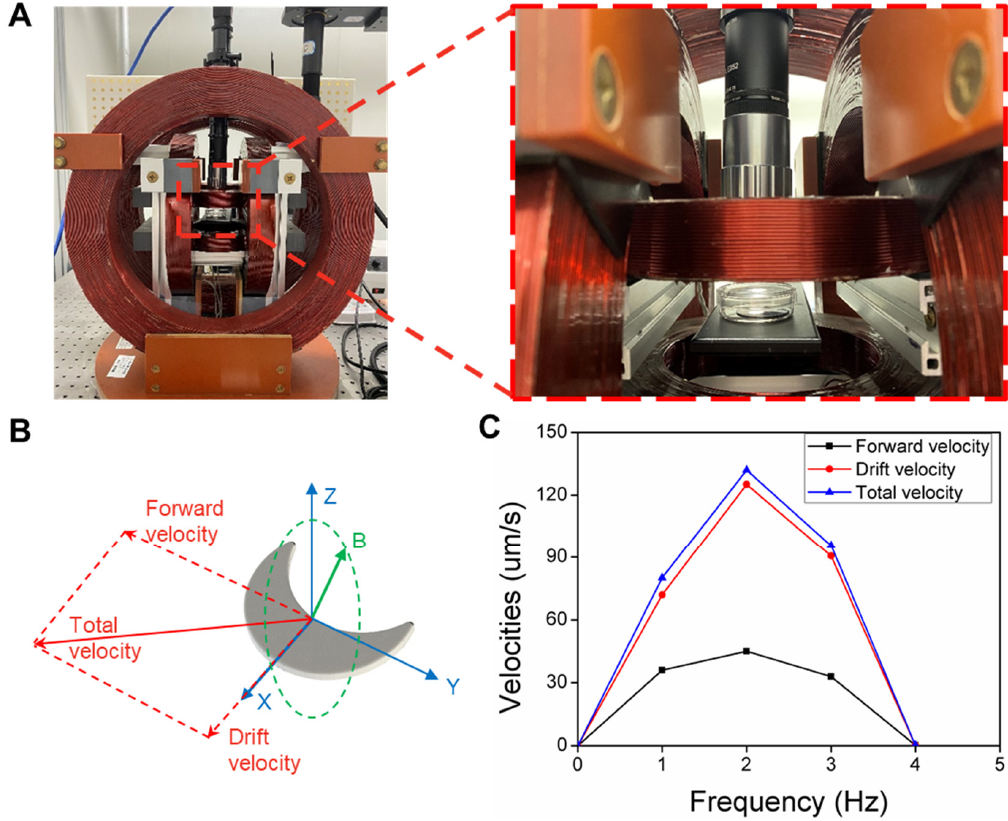
Figure 5. Biocompatibility test of the hydrogel crescent microswimmers. ( A ) Photograph of the magnetic control system. The zoomed-in image shows a sample of the microswimmers inside a petri dish placed at the central platform of the system. The position of the sample was adjusted to be as close as possible to the center of the coils to ensure field uniformity. ( B ) Schematic of a microswimmer and its swimming and drifting directions relative to the rotating magnetic field displayed in Cartesian coordinates. ( C ) The velocity profiles of the microswimmers. The step-out frequency is 2 Hz, and the maximum forward velocity is 42 μ m/s.